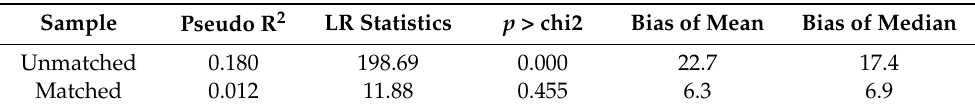
Figure 4. Standardized bias of covariates. Table 3. Balance test